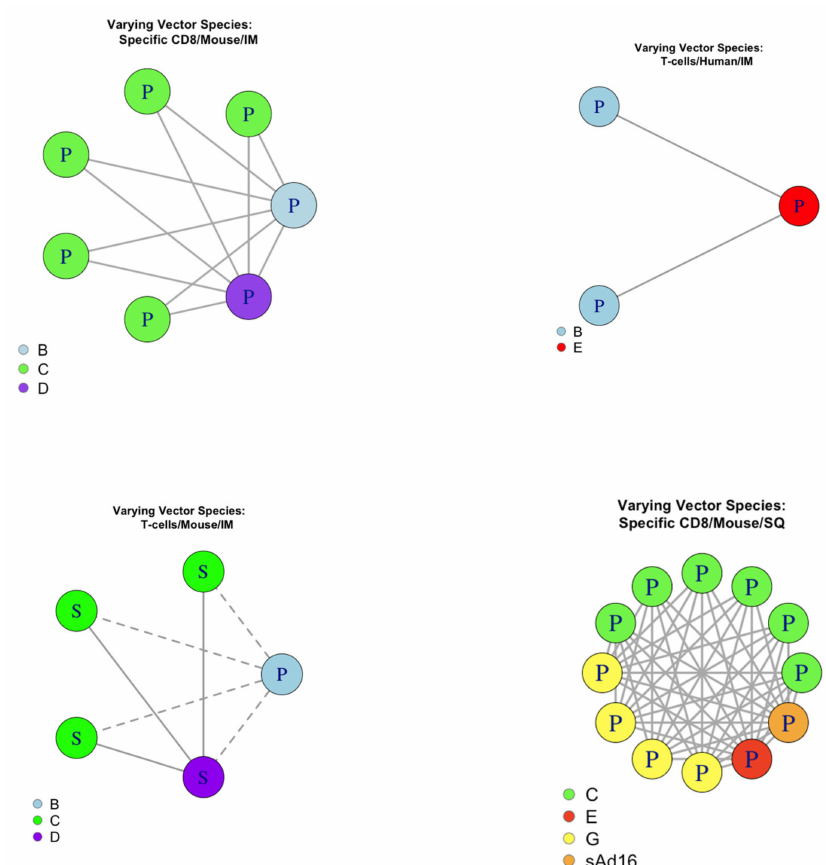
Figure 5. Pairings that di ff ered in host species examined for analysis of consistency between groups. Each point represents a dataset that provided evidence, where P / S denotes the dataset had evidence towards a peaking / saturating shape, respectively. Datasets were colour coded according to their vector species. A solid line shows consistent pairings and a dashed line shows inconsistent pairings. B = species B adenoviral vector. C = species C adenoviral vector. D = species D adenoviral vector. E = species E adenoviral vector. G = species G adenoviral vector. sAd16 = adenoviral vector was sAd16. IM = Intramuscular route of administration. SQ = Subcutaneous route of